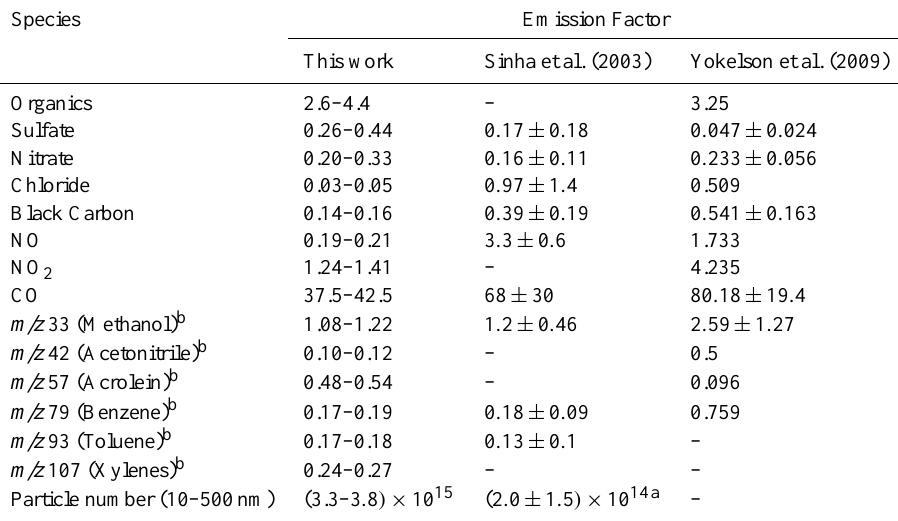
Table 2. Emission factors of particle and gas phase species emitted during olive tree branches burning for EF CO are in gkg − 1 except for particle number where the EF is in number of particles kg − 1 .